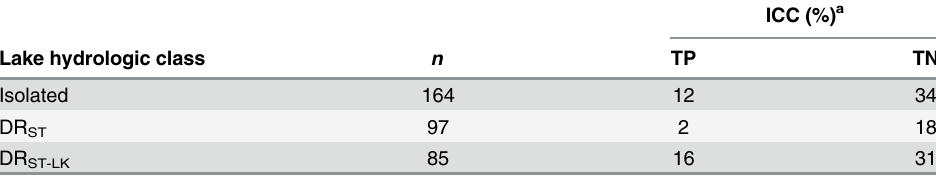
Isolated DR ST-LK 31 The models are for total phosphorus (TP) and total nitrogen (TN) with varying intercepts and no covariates, testing for regional differences in average lake nutrient concentration. Lake classes as for Table 1. a ICC = intraclass correlation coef fi cient, the percent of the total variation among lakes that is among-region